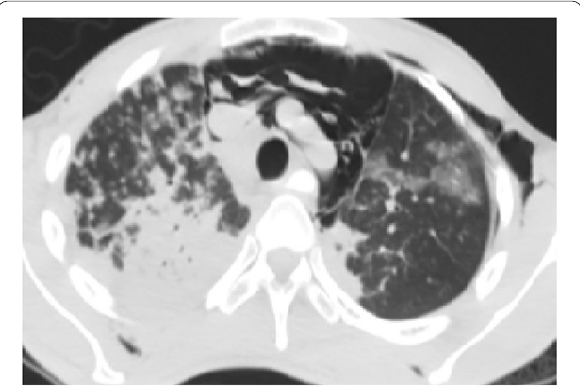
Fig. 1 Bilateral multilobar consolidation with pneumomediastinum and subcutaneous emphysema noted in the neck and chest